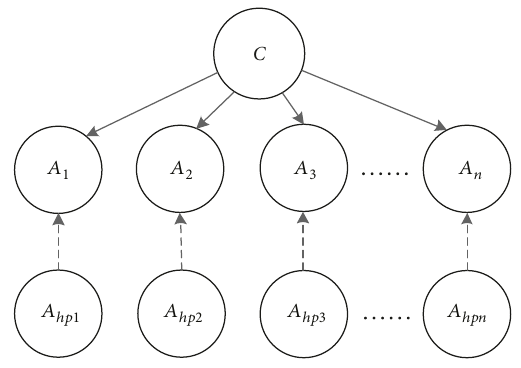
Figure 12: The structure of Hidden Na¨ıve